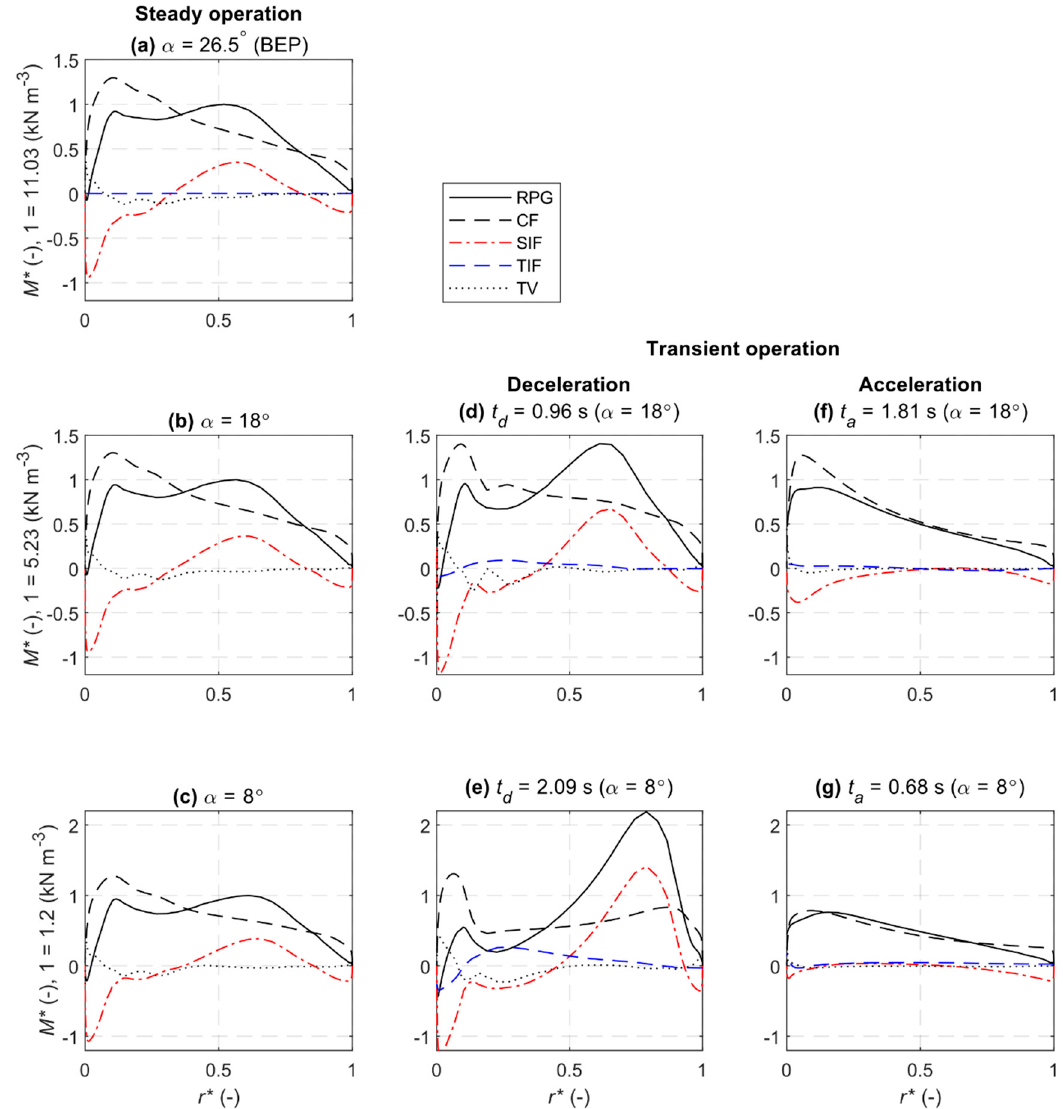
Figure 16. Variation of different terms at WK 2d for steady operations (a–c), deceleration (d and e) and acceleration (f and g). RPG: radial pressure gradient, CF: centrifugal force, SIF: spatial inertial force, TIF: temporal inertial force, VT: Viscous and turbulence term; see Equation (9).